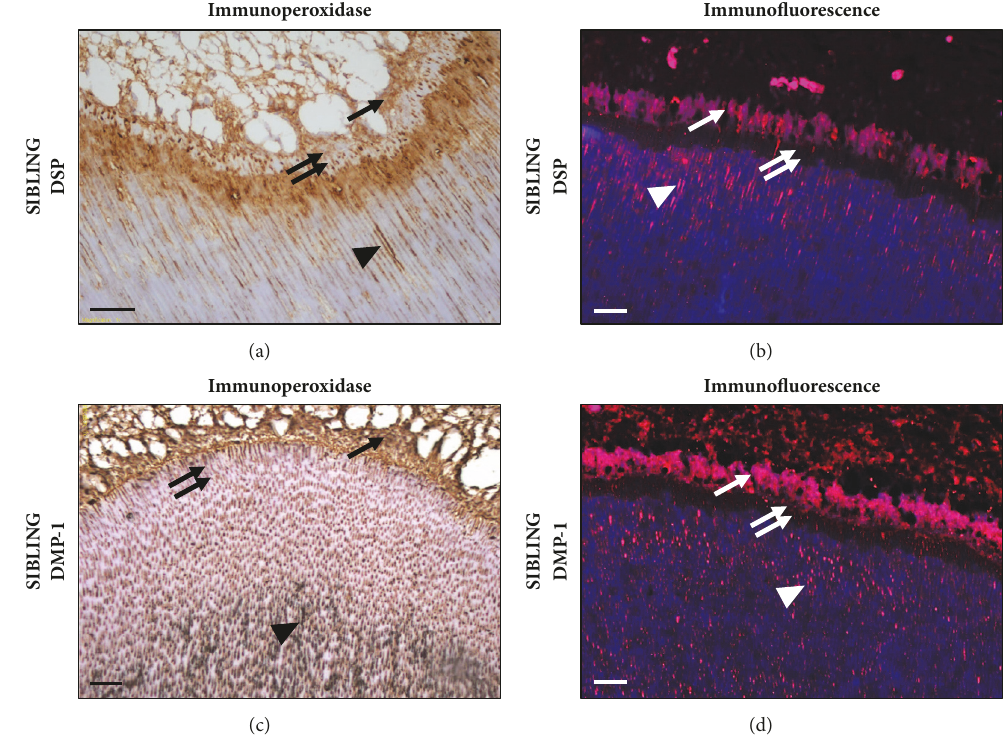
Figure 2: Location o f S IBLING proteins in minerali z ed dentin . An immunocytochemistry analysis using one of two primary antibodies, polyclonal antidentin sialophosphoprotein (Abcam, Cambridge, MA, USA) which is specific to dentin sialoprotein (DSP) or polyclonal antidentinal matrix protein (DMP)-1 (Sigma-Aldrich, St Louis, MO, USA) and visualized using peroxidase (brown color in (a) and (c)) or Alexa Fluor 594 (red color in (b) and (d)) coupled streptavidin under fluorescence microscopy revealed the localization patterns of DSP and DMP-1. DSP and DMP-1 are strongly expressed in the odontoblastic layer (arrow) and with less intensity in the predentin area (double arrow) and in the dentin mineralization front (head arrow). (a) and (b) immunopositive staining for DSP in the mineralized dentin. (c) and (d) immunolocalization of DMP-1. These non-collagenous proteins interact with collagen fibrils and control initiation and growth of apatite crystals on dentinal matrix. Mineralized dentin counterstainedwith hematoxylin(a and c) and Hoechst blue33342 (b and d). Bar corresponds to 100 𝜇 m. Courtesy of Baldion et al. [29].